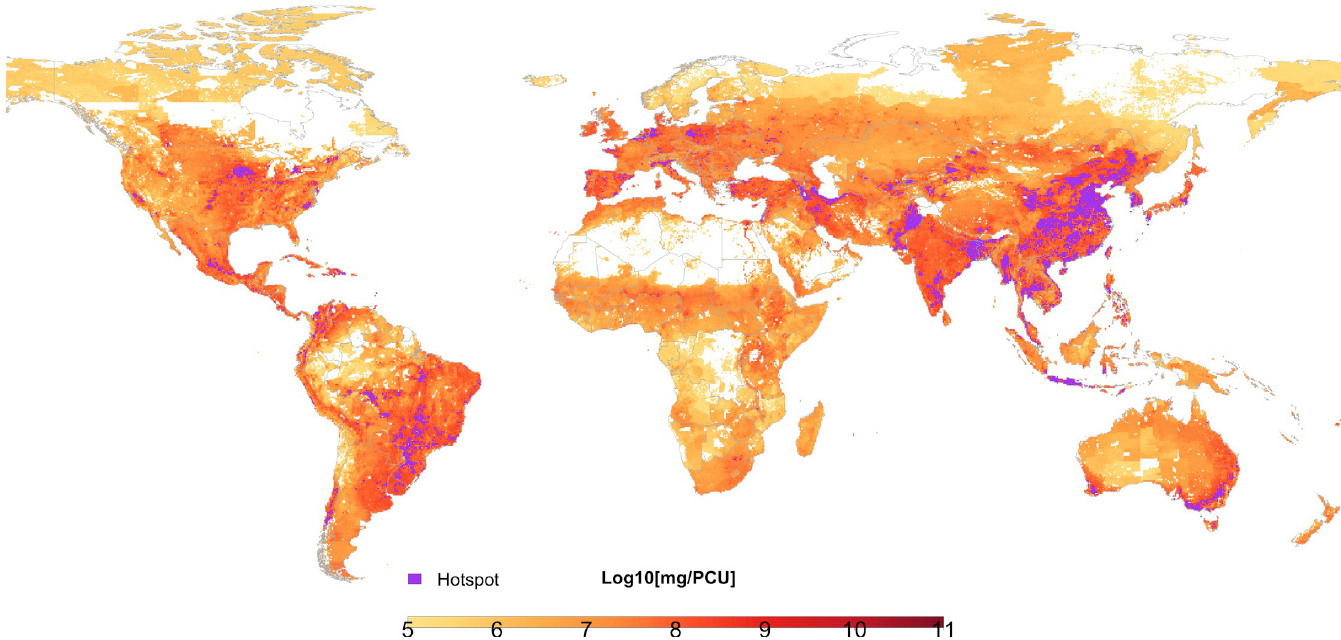
Fig 3. Global distribution of veterinary antimicrobial consumption at 10 x 10 kilometers resolution expressed in milligrams per biomass (population correction units). Purple indicates hotspot areas (top 95% percentile). Country boundaries were obtained from GADM (https://gadm.org/download_world40.html).